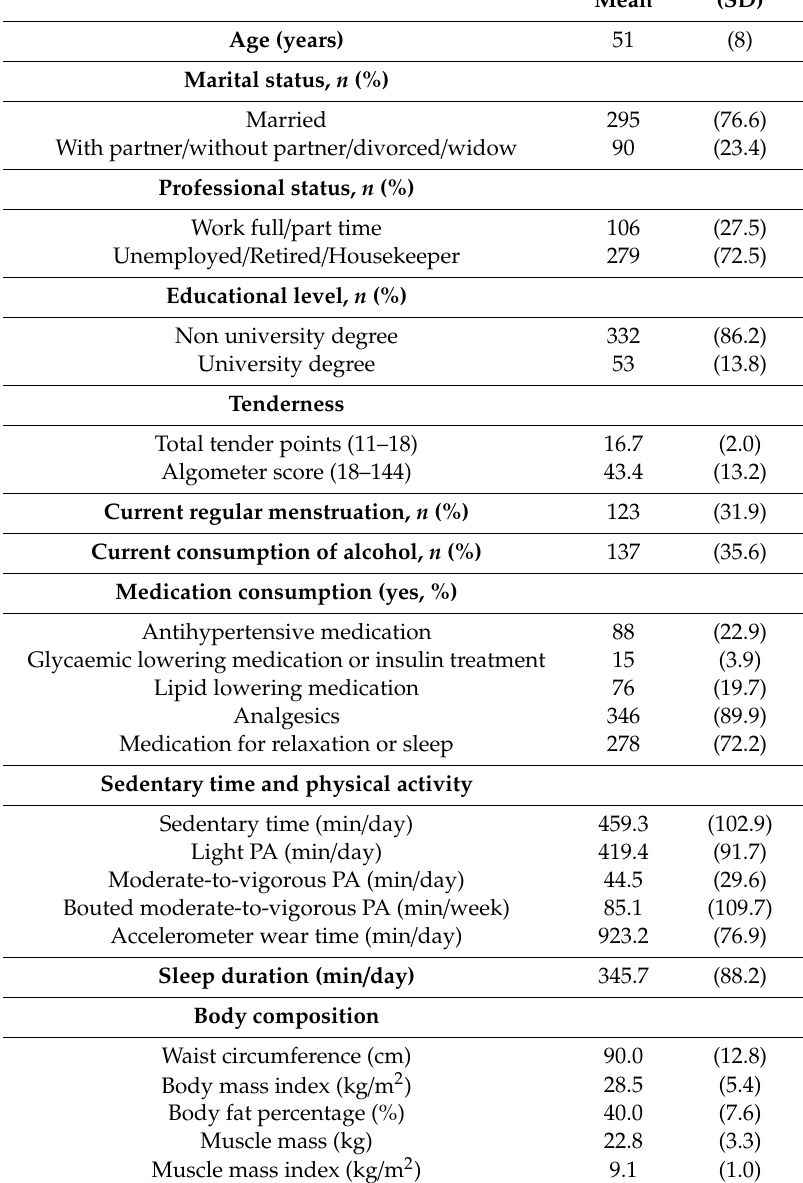
Table 1. Sociodemographic and clinical characteristics of the study participants ( n =